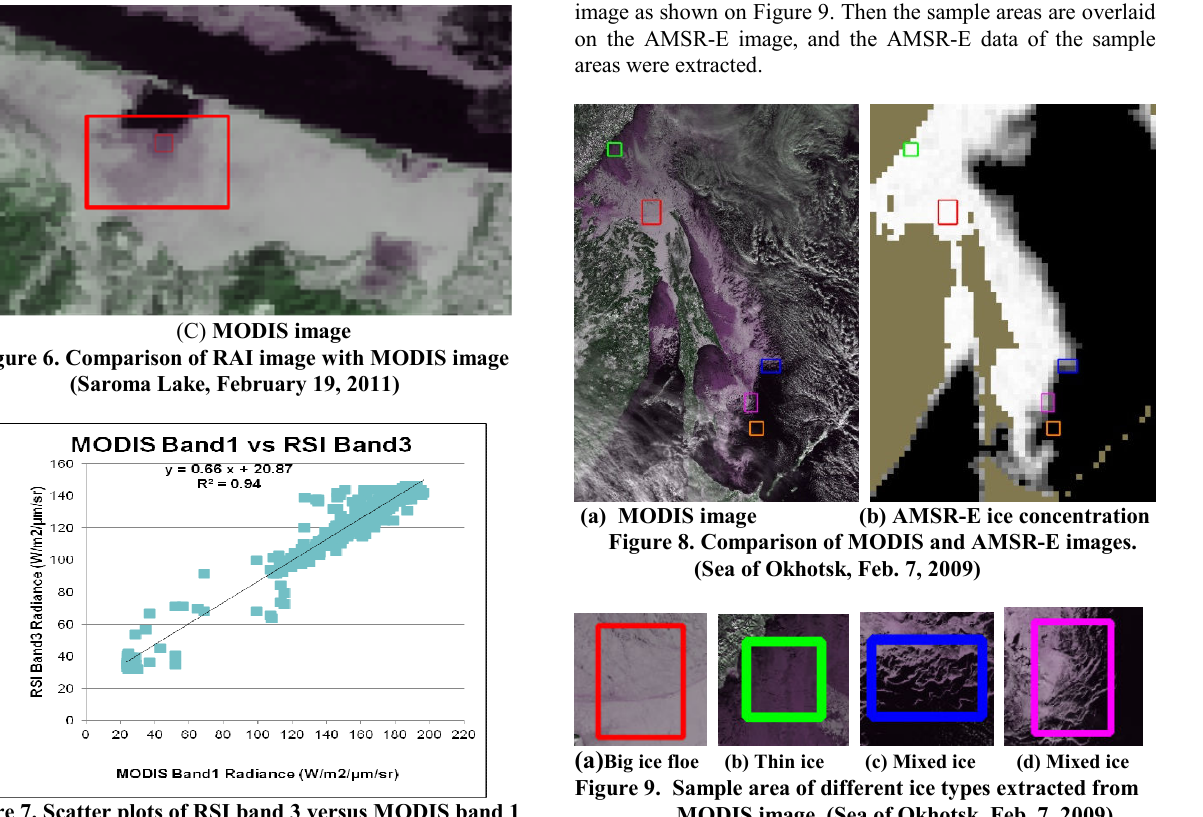
Figure 7. Scatter plots of RSI band 3 versus MODIS band 1 (Saroma Lake, February 19, 2011)